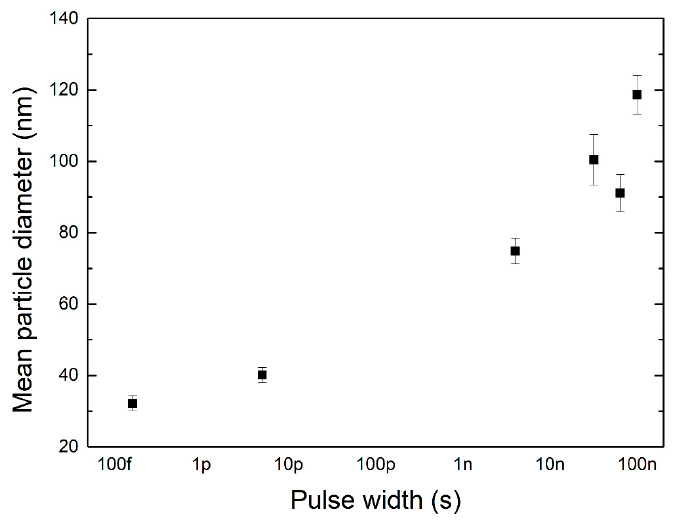
Figure 7. Mean nanoparticle diameter as a function of the pulse width.